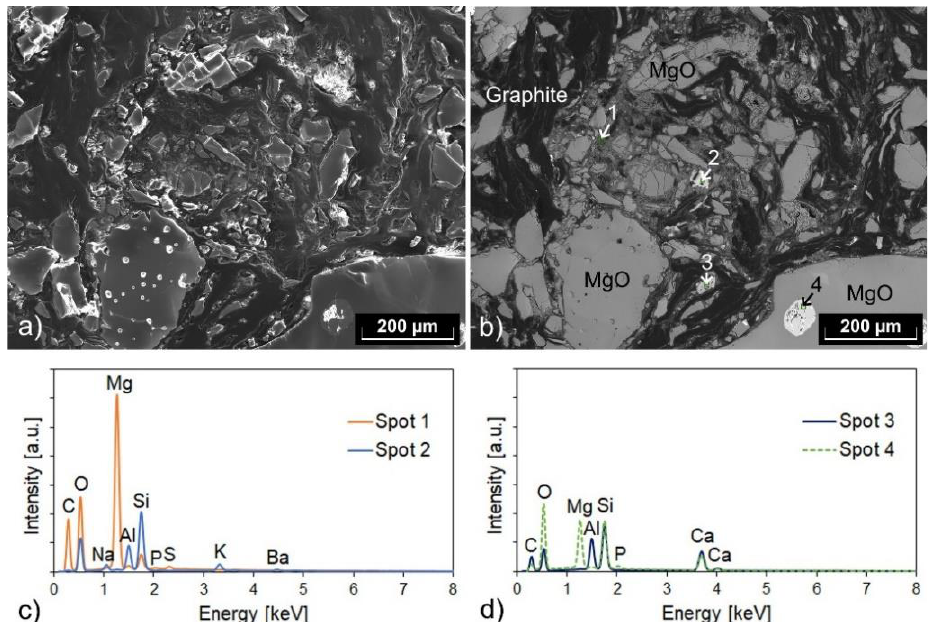
Figure 4. ( a ) Secondary electron and ( b ) backscattered electron micrograph of an aggregate from the recyclate fraction 1 – 3 mm, and ( c , d ) related results of EDS spot analyses (with the positions of the spots being marked in ( b )). The micrographs show a detail of the polished section seen in Figure 3b.